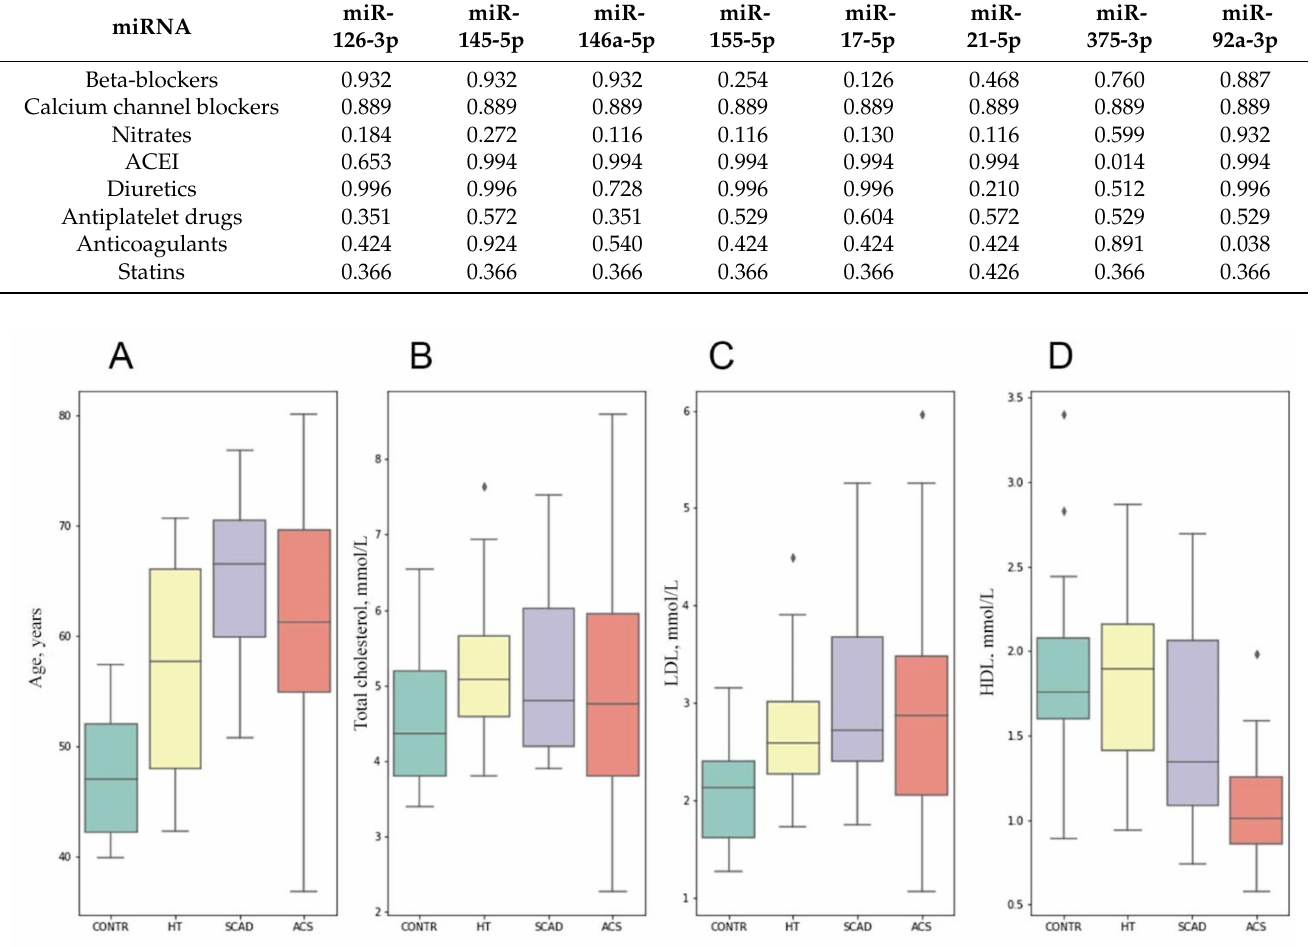
Table A3. p -values of significance of relationship between medical therapies potentially influencing platelet state and miRNA relative plasma levels obtained by MLR analysis in a combined HT+SCAD+ACS group (n = 106). ACEI, angiotensin- converting enzyme inhibitors.